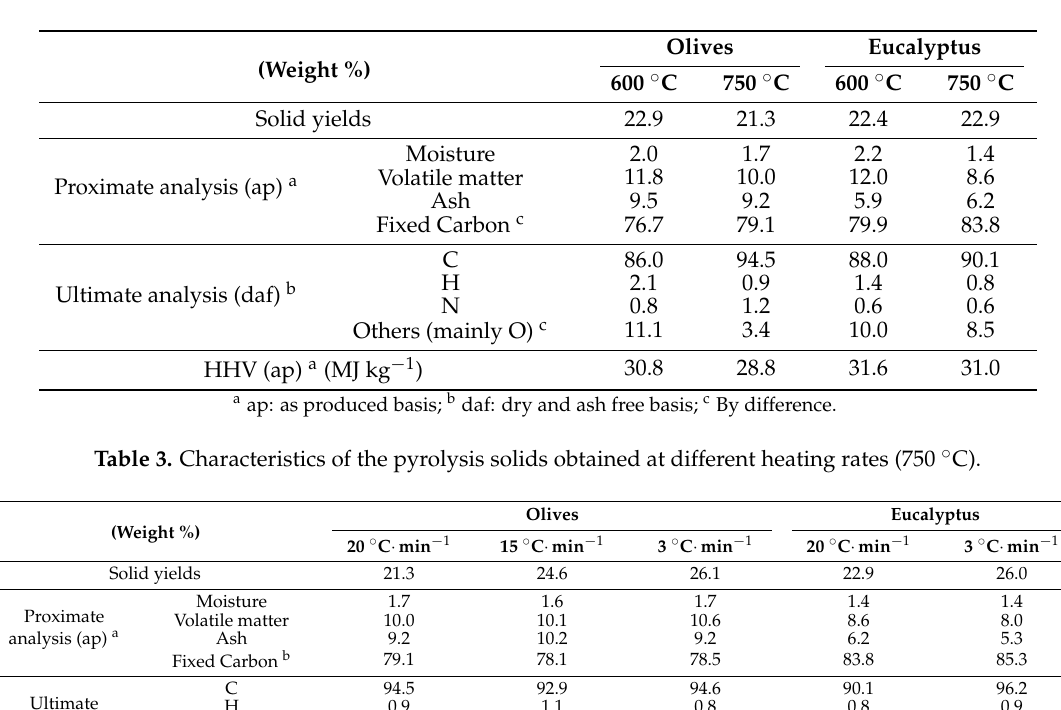
Table 2. Proximate and ultimate analyses of the pyrolysis solids obtained at different temperatures (20 ˝ C ¨ min ´ 1 ).